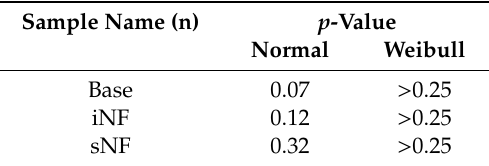
Table 4. Goodness of fit test